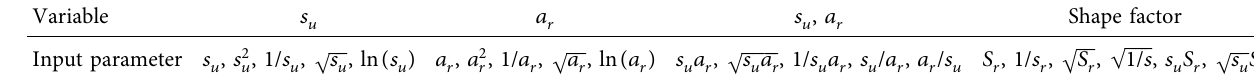
Table 2: Various types of input variables for MLR modeling (Approach 1).